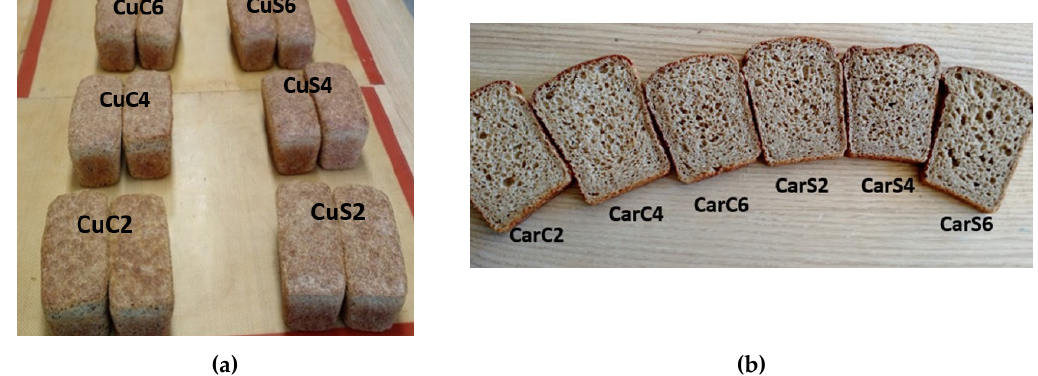
Figure 1. Bread fortified with cumin ( a ) and caraway ( b ) seeds and by ‐ products.CuC2: 2% of cumin cake; CuC4:4% of cumin cake; CuC6: 6% of cumin cake; CuS2: 2% of cumin seed powder; CuS4: 4% of cumin seed powder; CuS6: 6% of cumin seed powder; CarC2: 2% of caraway cake; CarC4: 4% of caraway cake; CarC6: 6% of caraway cake; CarS2: 2% of caraway seed powder; CarS4: 4% of